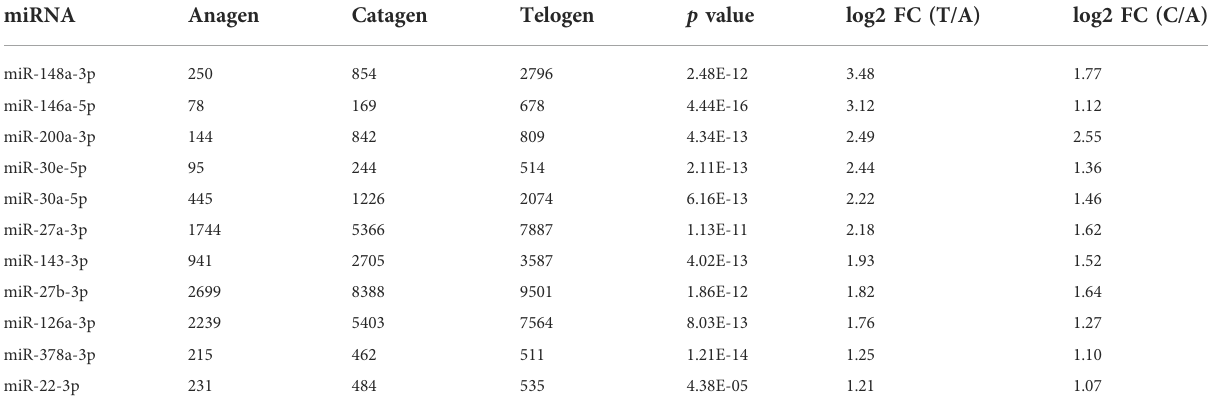
TABLE 1 A set of miRNAs with increasing expression from the anagen to telogen phase in murine hair follicle cycle.